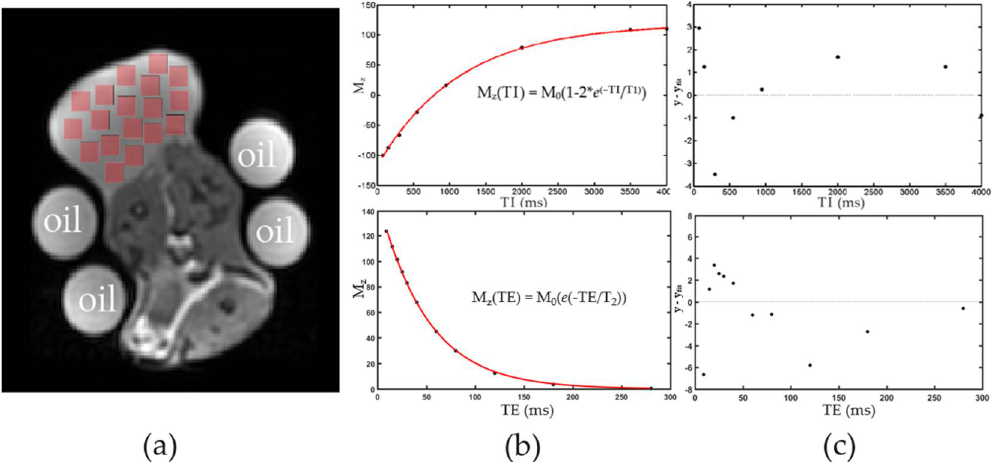
Figure 2. Example of T 1 and T 2 curve fit and analysis. ( a ) Example image through the center mass of the tumor. Signal intensity in each square ROI was averaged and contributes to one point in a T 1 or T 2 plot. ( b ) T 1 plot (top) and T 2 plot (bottom) was approximated as a single exponential recovery/decay. ( c ) Residuals from the fits in ( b ).